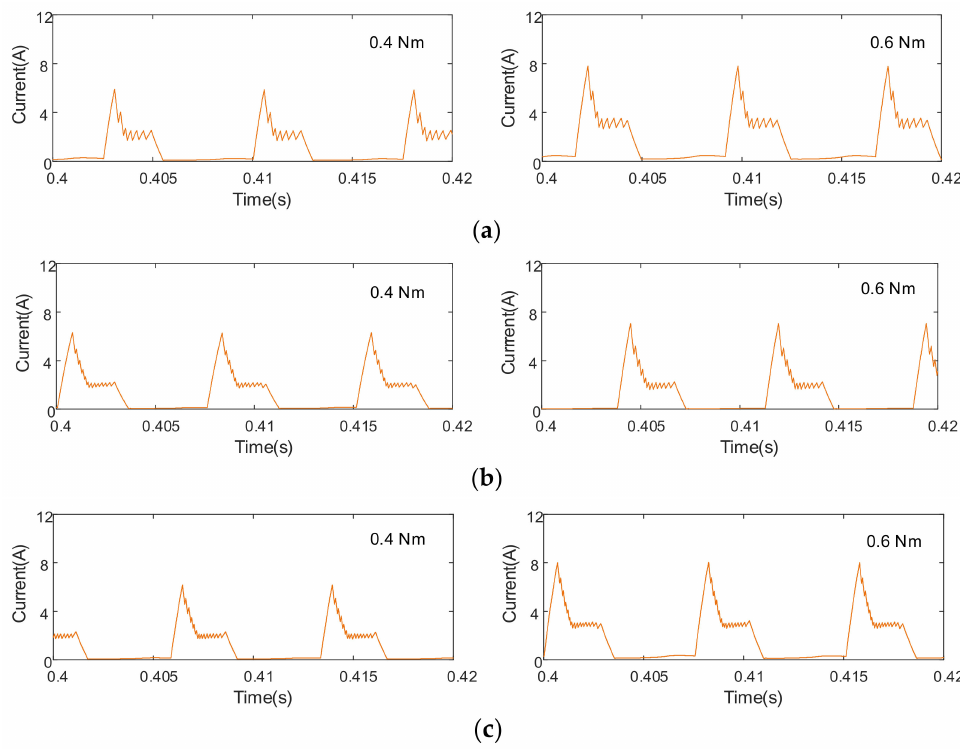
Figure 12. Current with varied load torque. ( a ) Method 1, ( b ) method 2, and ( c ) method 3.